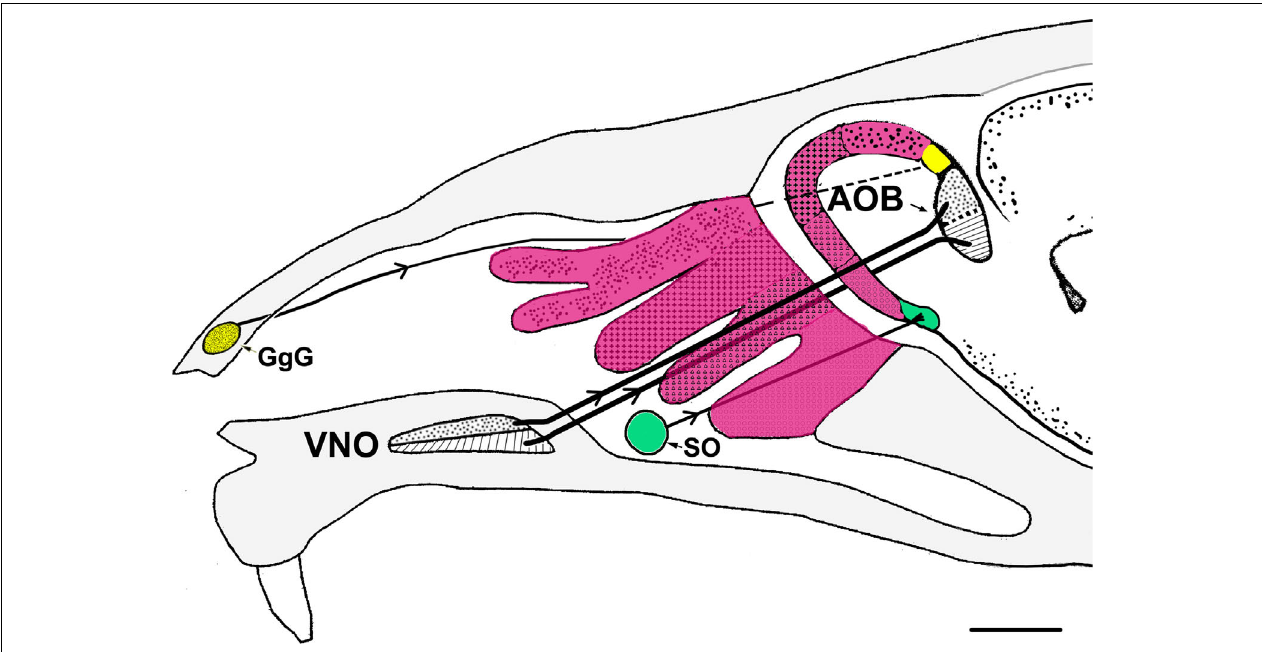
FIGURE 2 | Schematic representation of a parasagittal section through part of the head of a mouse depicting the different olfactory receptors and their projections to the bulbs. Four zones of the main olfactory receptors-four zones of MOB (fuchsia).